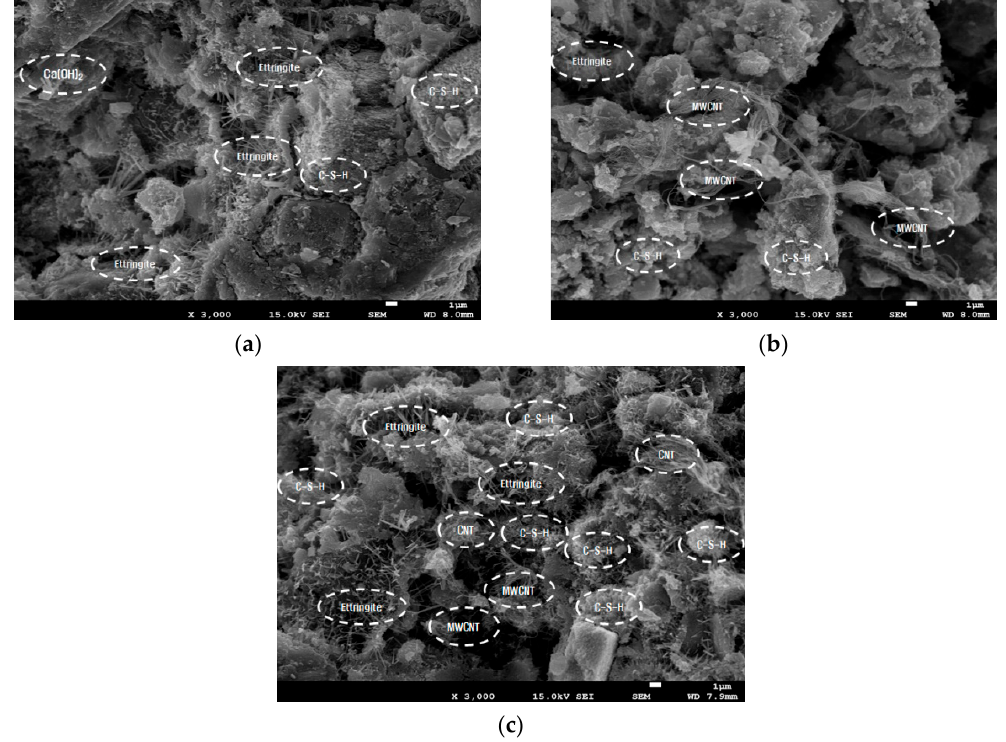
Figure 12. SEM images. ( a ) MW-P1.0; ( b ) MW-P2.0; and ( c ) MW-L.